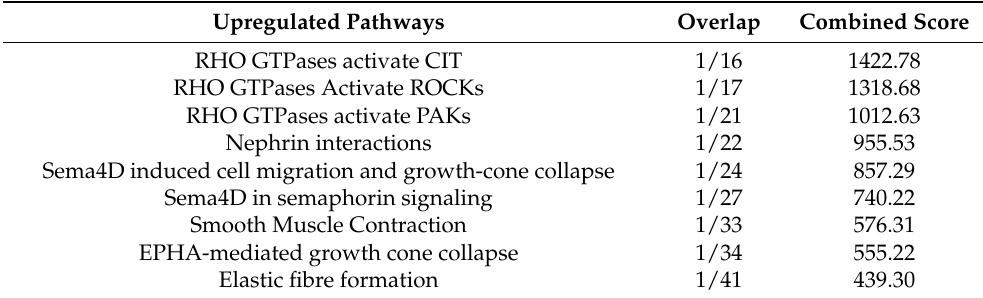
Table 2. Upregulated pathways for the infarct core compared to infarct border (green vs. orange), with an adjusted p -value <0.05 and ranked by the combined score 1